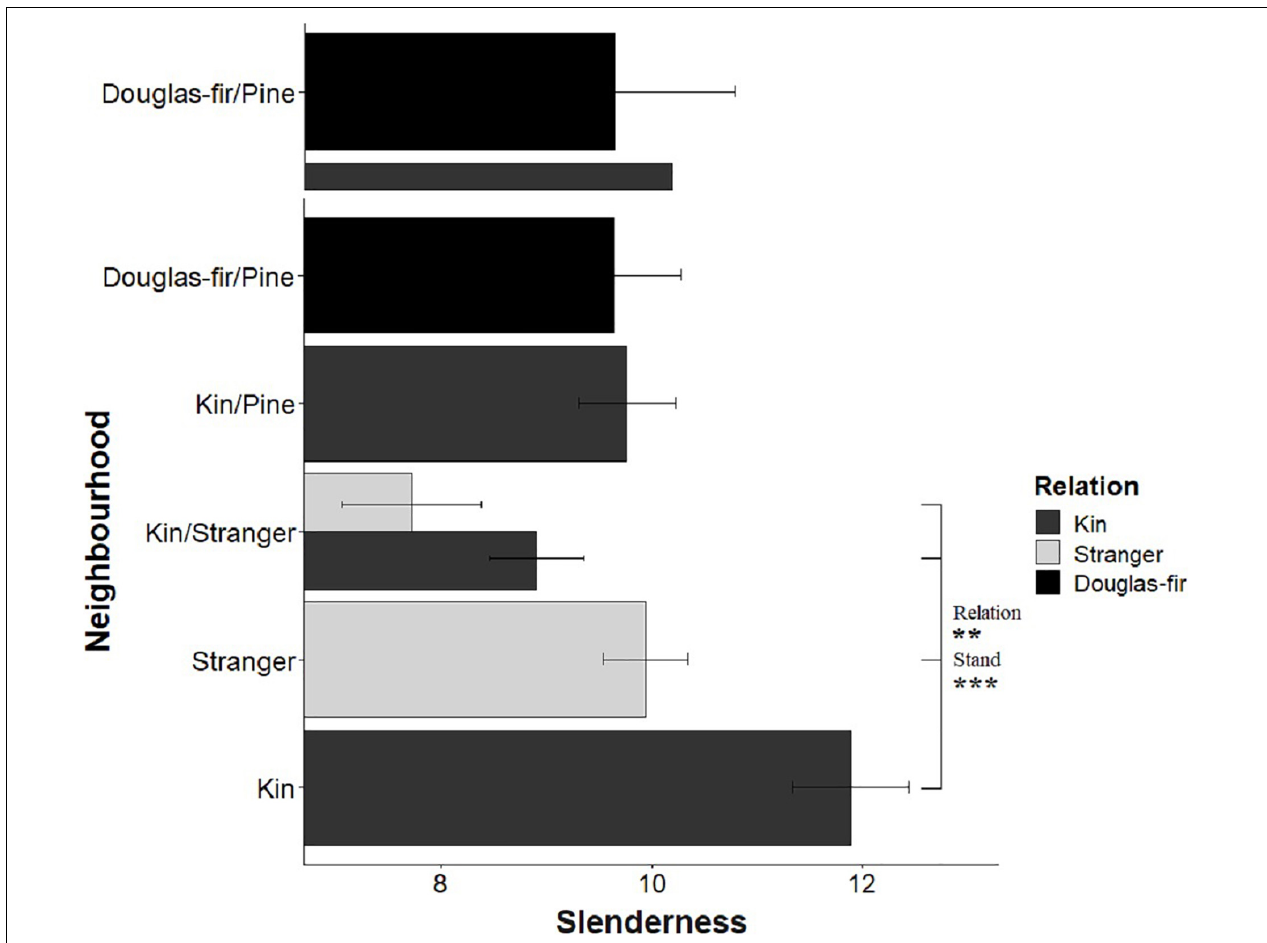
FIGURE 9 | Estimated marginal means from planned contrasts ( Table 2 ) relation (estimate = –3.13, t ratio = –2.97, p = 0.0034. Df = 192), stand (estimate = 5.20, t ratio = 4.93, p < 0.0001, Df = 192), inter- vs. intraspecific neighbor (kin pair with intra- or interspecific as the neighbor) (not significant) and presence and number of pine seedlings (not significant) on the different slopes linear model slenderness: height ∼ diameter + Neighborhood × Family + diameter: Neighborhood. ** p < 0.01 and *** p <